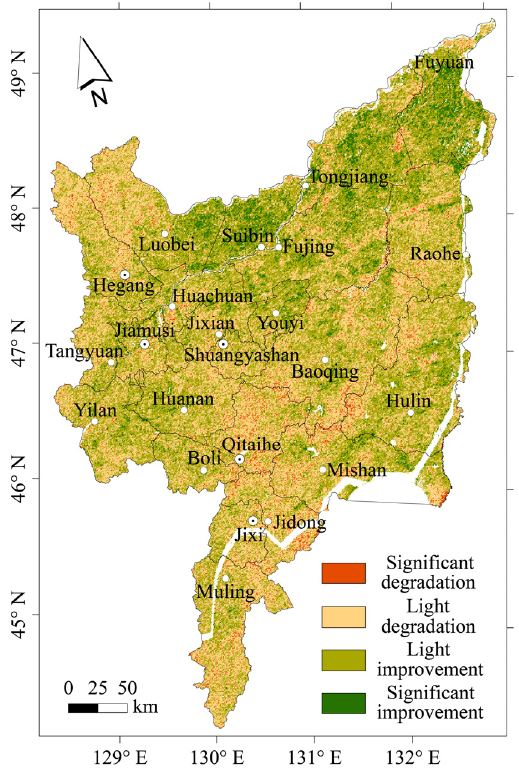
Figure 8. Spatial variation of CI GS .